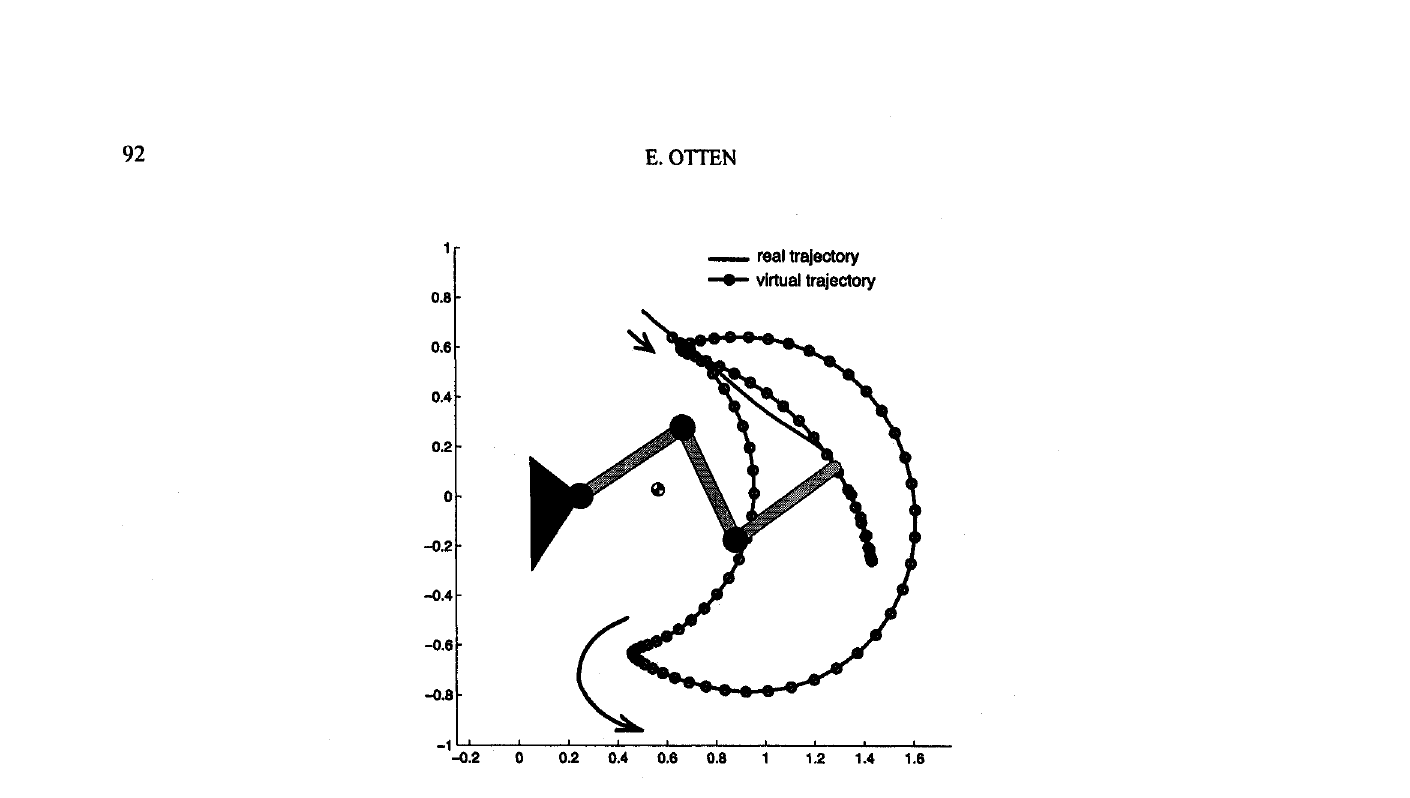
Fig. 3: Virtual and real trajectory of a fast movement of a simulated articulated limb. Note the complex shape ofthe virtual trajectory for this simple straight line endpoint movement with bell-shaped velocity profile. The complex shaped virtual trajectory is due to the fact that the real limb needs to be accelerated and decelerated while its endpoint remains on a straight path.